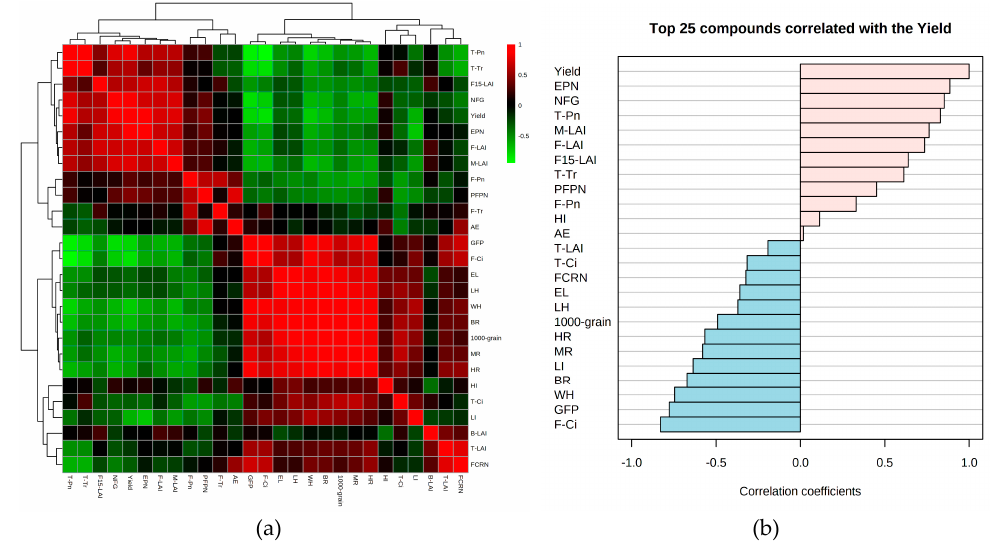
Figure 5. Correlations of the investigated parameters. ( a ): Coordinate chart of correlation of each parameter. ( b ): Top 25 compounds correlations with the yield. T-LAI: leaf area index at the tillering stage. B-LAI: leaf area index at the booting stage. F-LAI: leaf area index at full heading stage.